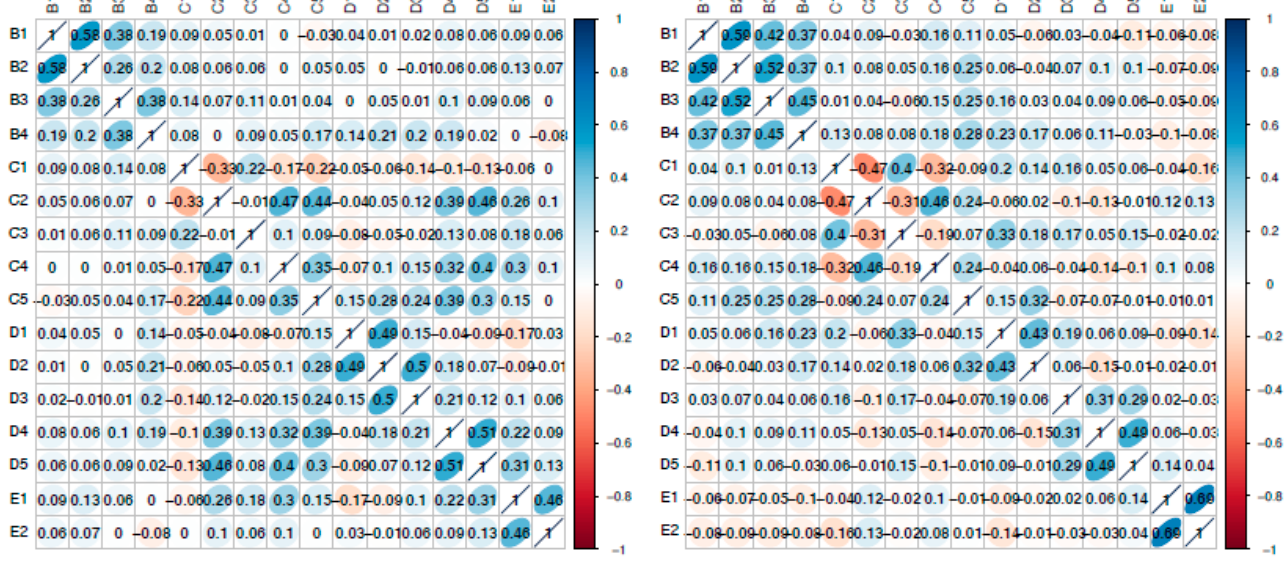
Figure 1. Spearman rank correlation matrices for medical students ( a ) and dental students ( b ) sepa- rately for each question in the questionnaire. The color bar indicates the correlation coefficient the dark blue positive correlation and orange colors negative correlation.